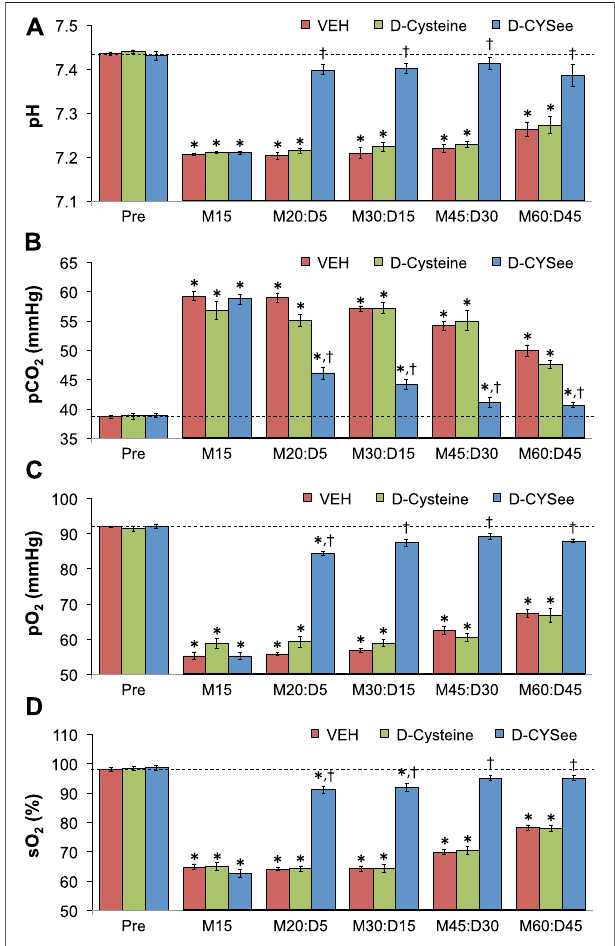
FIGURE 7 | Values of pH (Panel (A) ), pCO 2 (Panel (B) ), pO 2 (Panel (C) ), and sO 2 (Panel (D) ) before (Pre) and after injection of morphine (10 mg/kg, IV) in three separate groups of freely-moving rats followed by injection of vehicle (VEH (saline), IV), D-cysteine (500 μ mol/kg, IV), or D-cysteine ethyl ester (D-CYSee, 500 μ mol/kg, IV). The terms M15, M20, M30, M45, and M60 denote 15,30, 45,and 60 minafter injection ofmorphine. Theterms D5,D15, D30, and D45denote 5,15, 30, and 45 min after injection ofthedrug (vehicle, D-cysteine, or D-CYSee). The data are mean ± SEM. There were 8 rats in the vehicle- or D-CYSee – treated groups and 6 rats in the D-cysteine – treated group. * p < 0.05, signi fi cant change from pre-values. † p < 0.05, D-CYSee versus vehicle.